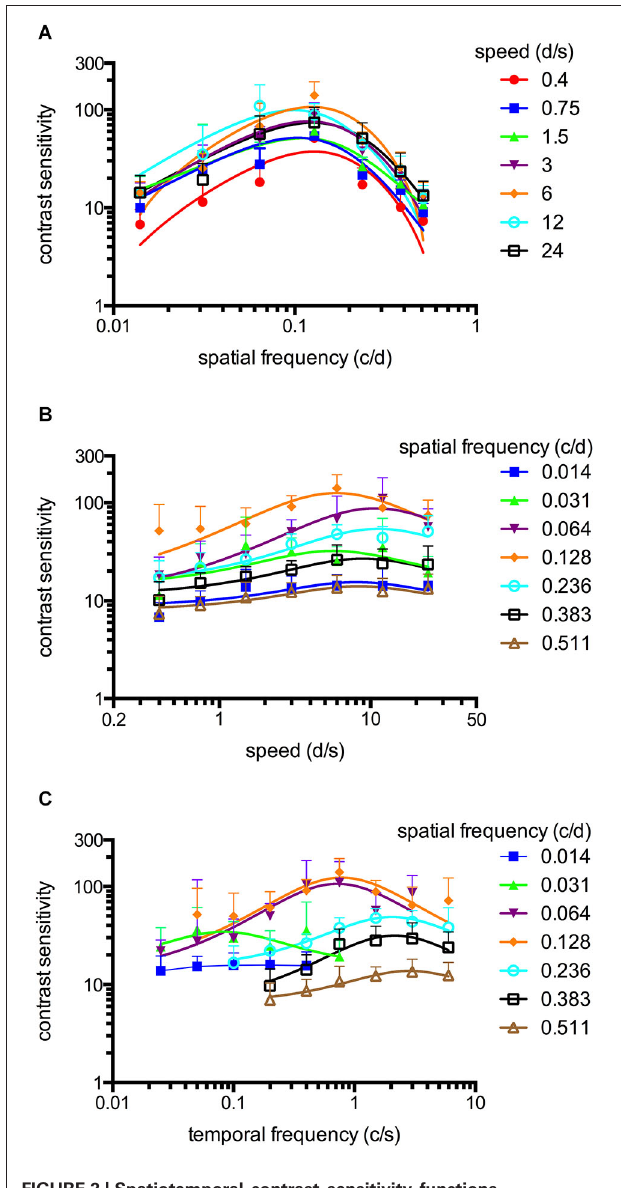
FIGURE 2 | Spatiotemporal contrast sensitivity functions (CSFs) of adult zebrafish at a constant photopic light level (1.8 log cd m − 2 , n = 6 animals). (A) CSFs of varying speed measured at spatial frequencies ranging from 0.014 to 0.511 cycles/degree (c/d). (B) CSFs measured at speed levels ranging from 0.4 to 24 degrees/second (d/s). (C) CSFs measured at temporal frequencies ranging from 0.025 to 6 cycles/second (c/s). Error bars indicate the standard